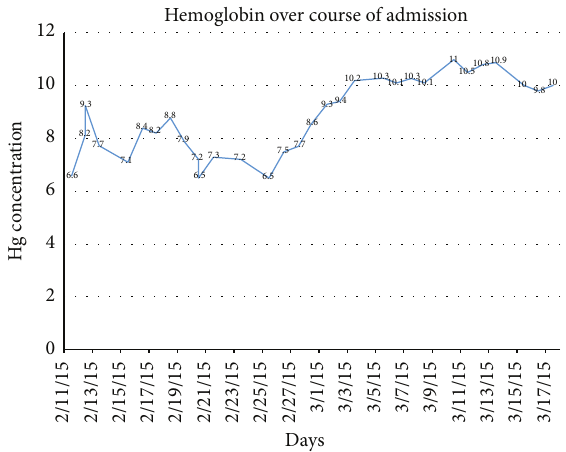
Figure 4: Hemoglobin concentration through patient’s